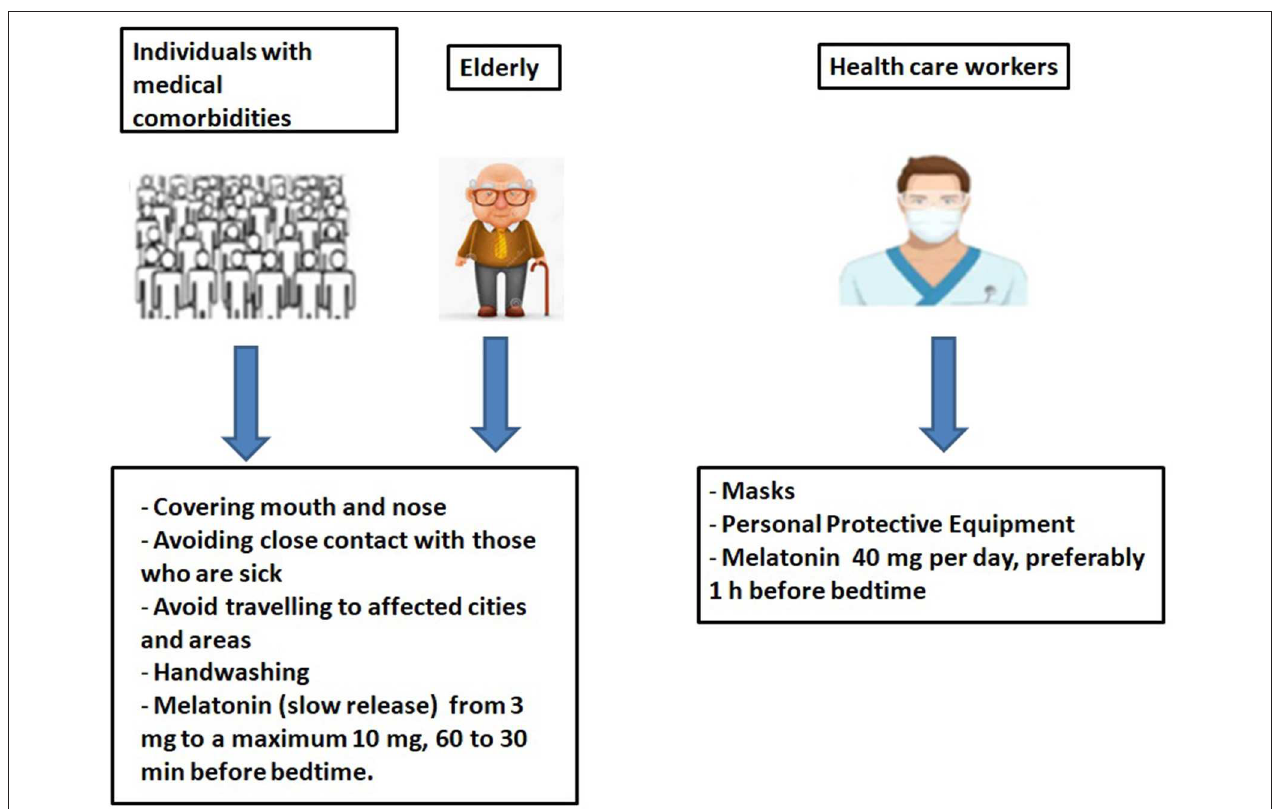
FIGURE 1 | Prevention of COVID-19 infections in the elderly, in individuals with comorbidities and in health care workers.